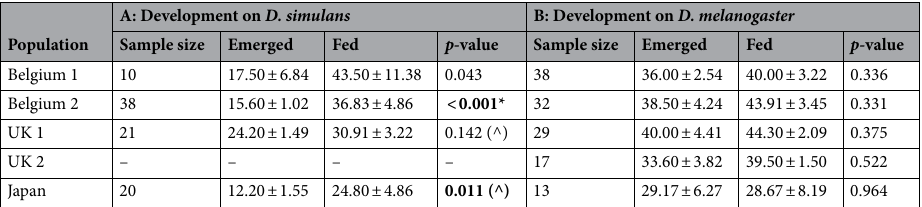
Table 1. Wasps synthesize fat in a fat-poor environment. Mean absolute fat amount ± 1se (in μg) was quantified in adult wasps from field-caught L. heterotoma . Independent experiments were performed for each population and on each host species (lean D. simulans , A; fat D. melanogaster , B) comparing fat content of recently emerged females with females that fed for 7 days. P -values reveal whether 7 days of feeding led to a significant overall increase (after correction for multiple testing; in bold) in fat content compared to teneral fat levels at emergence, indicating that fat synthesis had occurred. Two of the four populations tested on D. simulans showed increased fat content and fat synthesis on the lean host, but not on the fat host. T-tests were performed when data was normally distributed and variances equal with (^) or without log transformation. Welch’s t-test was used when variances remained unequal (*). Population UK2 was not available for testing on D.